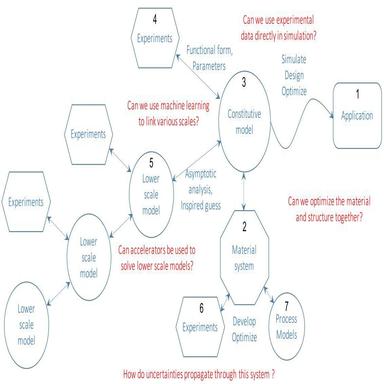
The framework of application-driven materials by design.